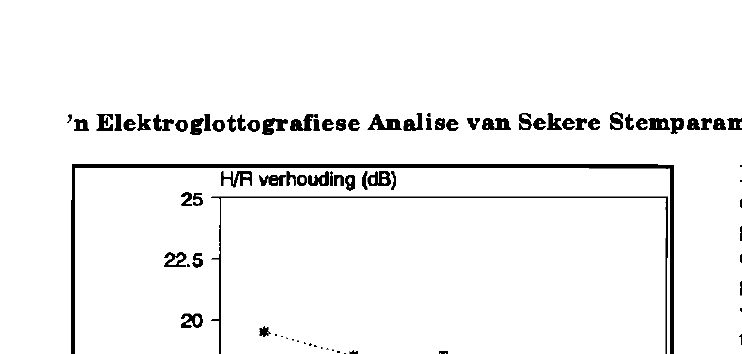
Die H/R-verhoudingswaarde van per- sone in verskillende ouderdomsgroepe tydens produksie van la.il en liil met normale en verhoogde luidheid.